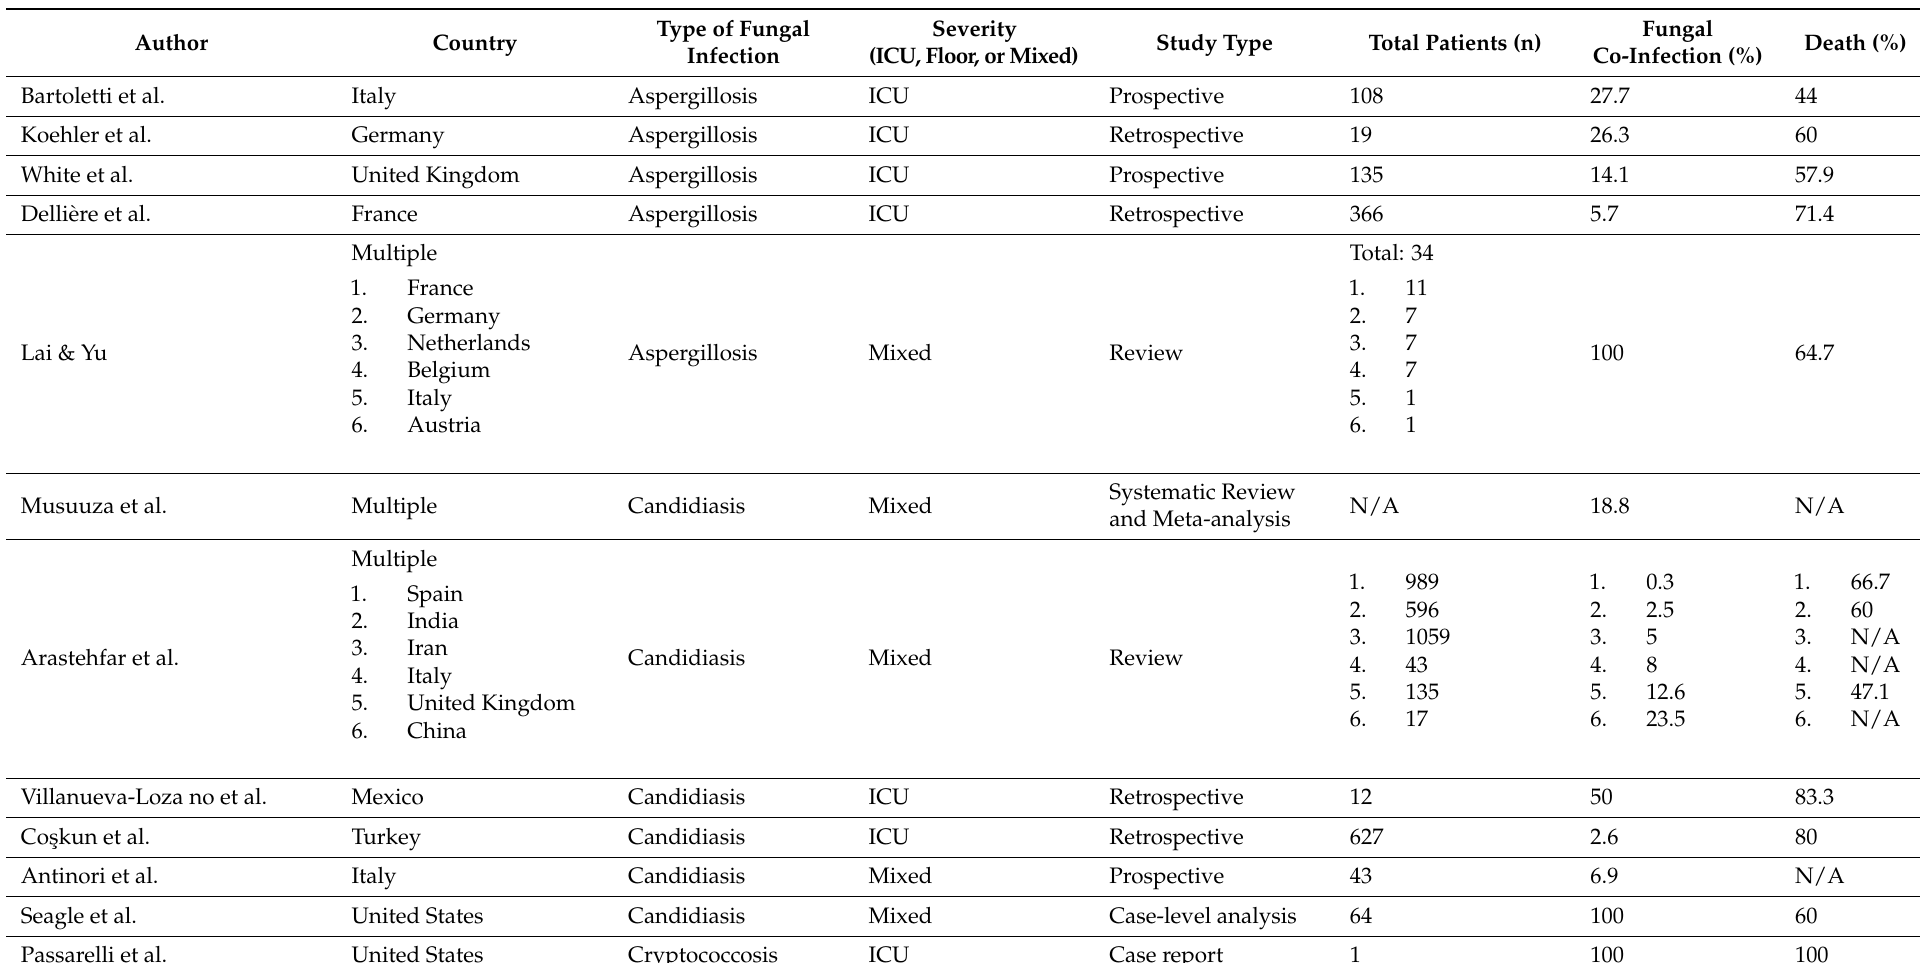
Table 2. Summary table of fungal coinfection findings by country (n= total number of patients).